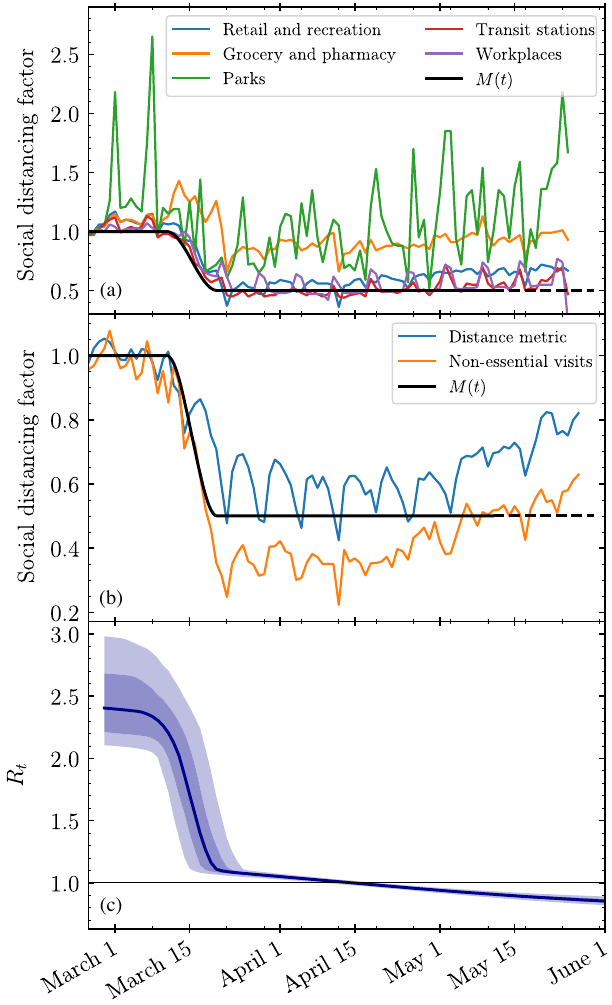
FIG. 6. The time-dependent mitigation factor M ð t Þ defined in Sec. II A as inferred from model fits compared to measures of mobility in Illinois provided by Google (a) and Unacast (b). In panel (c), we also plot the inferred evolution of R t as defined in Eq. (3), which we draw from a calibration to data from the entire state of Illinois through May 17, 2020. Shaded regions denote the 68.4% (lighter shading) and 95.6% (darker shading) confidence intervals, while the solid curve denotes the